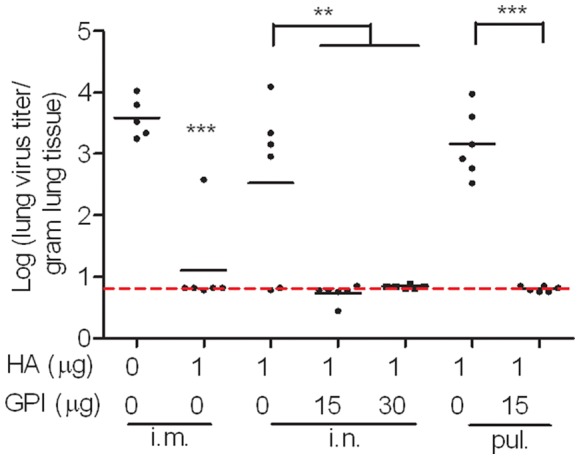
Effects of unadjuvanted and GPI-0100-adjuvanted mucosal influenza vaccine on lung virus titers.Mice were immunized on day 0 and on day 20 with 1 µg A/PR/8 subunit vaccine alone or adjuvanted with the indicated doses of GPI-0100. The control mice received HBS buffer. The immunizations were given via intramuscular (i.m.), intranasal (i.n.) or intrapulmonary (pul.) route. 2 weeks after the second immunization, mice were infected with live A/PR/8 virus. Lung samples were collected 3 days later upon termination. Virus titer is expressed as the 10log virus titer per gram of lung tissue for individual mice. The black line represents the geometric mean virus titer per group. One mouse from the HBS control group was sacrificed before the challenge due to abnormal tissue growth with unknown reason. Levels of significance are depicted as follows: *p<0.05, **p<0.01 and ***p<0.005.